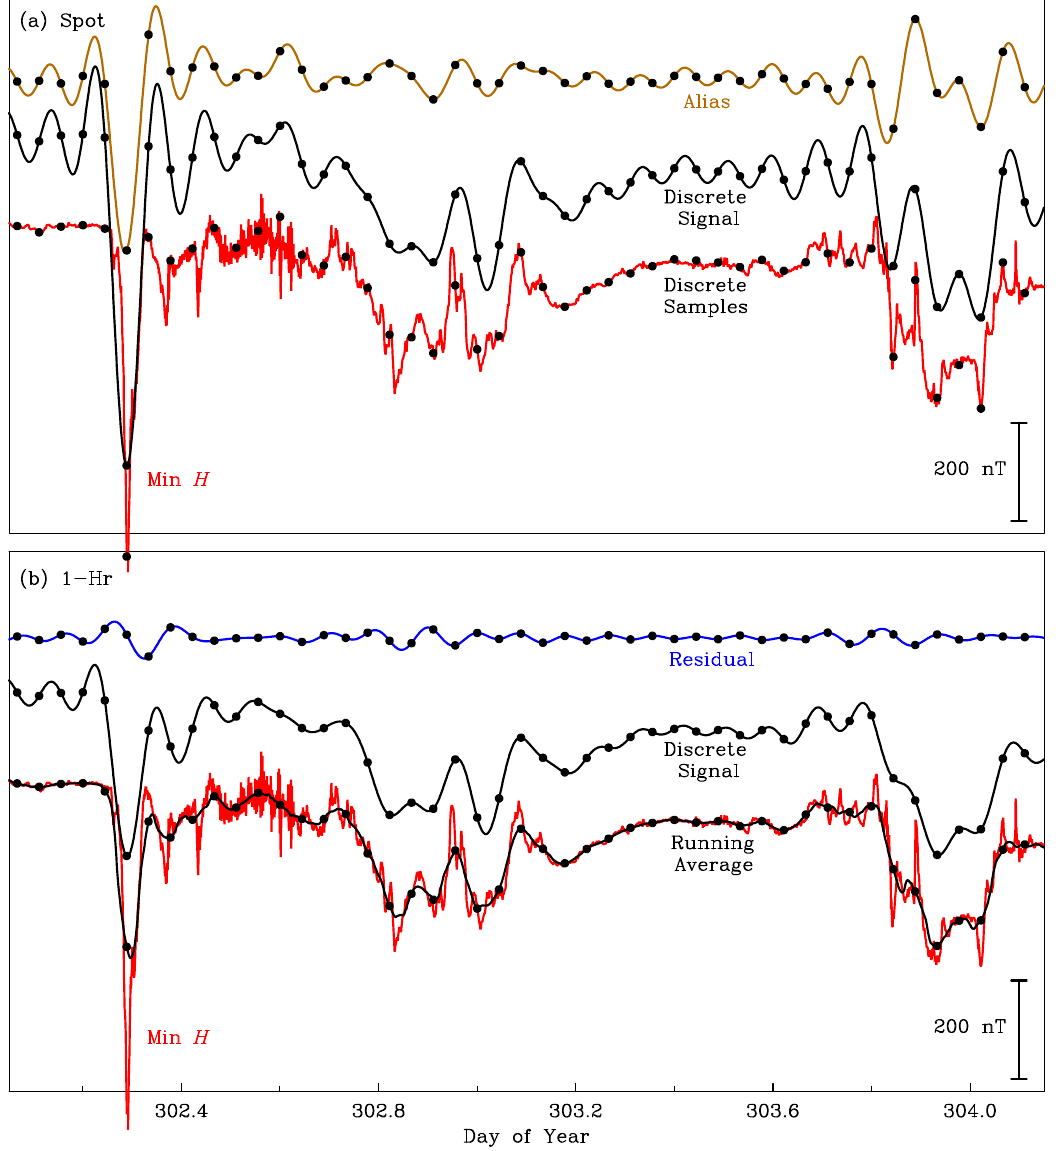
Fig. 2. Data from CLF recording 2 days of horizontal-intensity magnetic-field variation during the Halloween storm of October 2003: 1-min data H(t) (red), running averages H a (t) (black), signal of discrete samples H as (t) (black), alias S s (t) (brown), low-frequency residual L as (t) (blue), and discrete samples (black dots), each for (a) instantaneous, spot samples H s (t j ) and (b) 1-h average-samples H 1s (t j ) . terms – those differences are due to amplitude